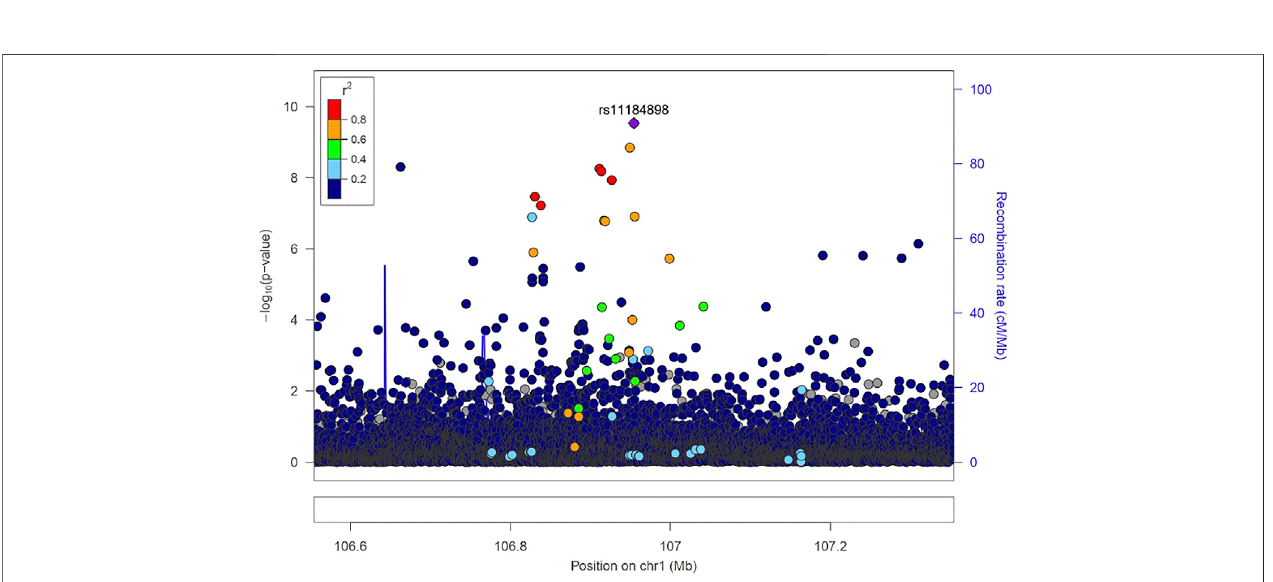
FIGURE 3 | Locus zoom regional association plot for